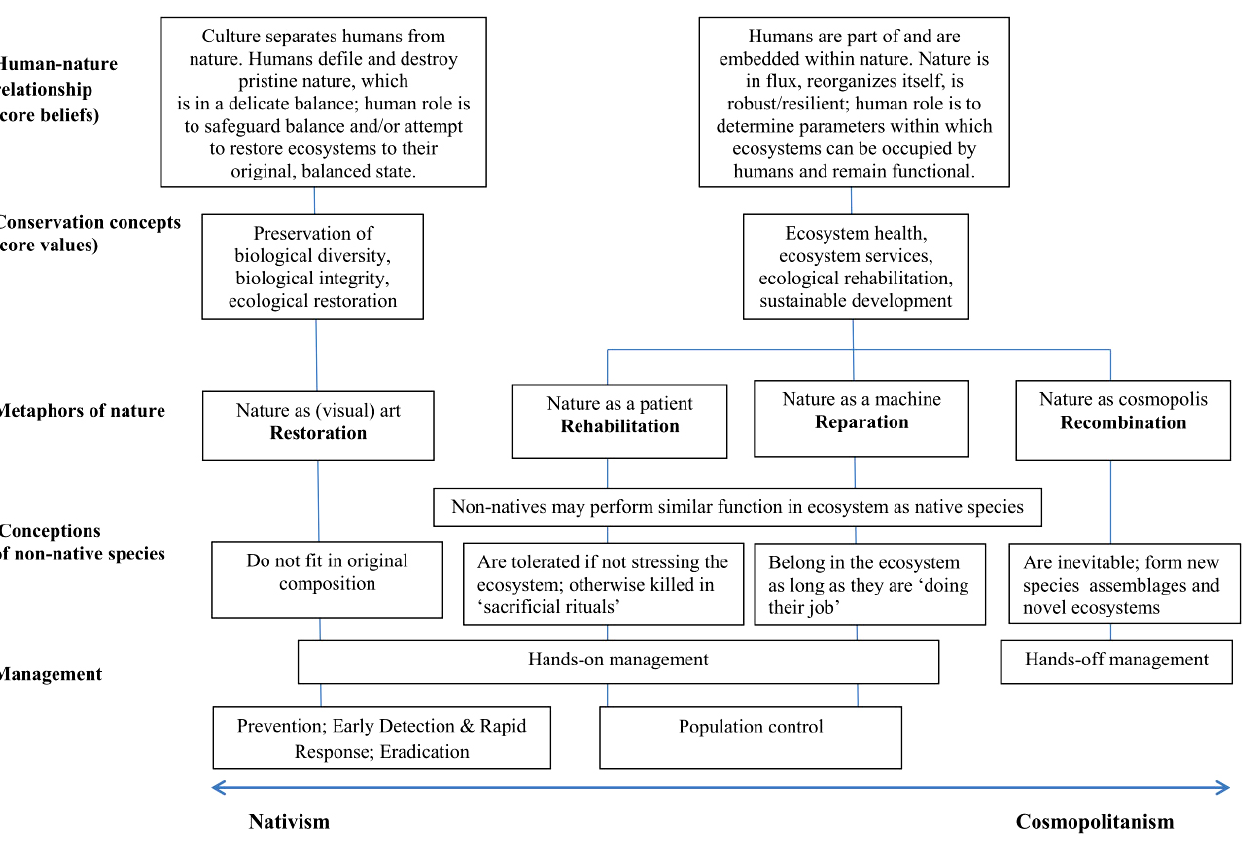
Fig. 1 . Conceptualizations of nature and implications for non-native species management (based on Callicott et al. 1999 and Keulartz and van der Weele